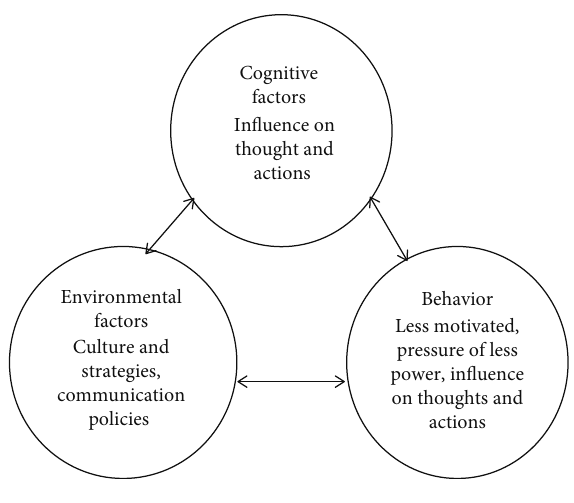
Figure 16: Social cognitive theory [42,